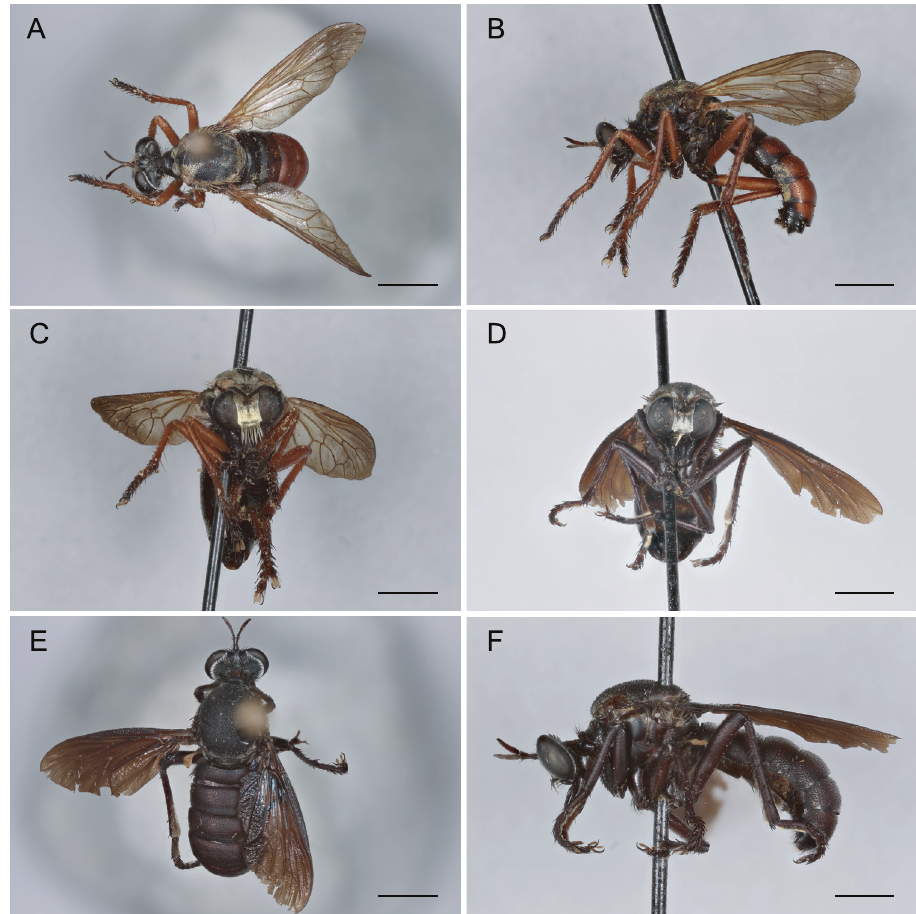
Figure 6. Saropogon abbreviatus Johnson, 1903 Female (USNMENT01830071): A dorsal view B lateral view C anterior view; Male (USNMENT01830070): D anterior view E dorsal view F lateral view. Scale bars: 2